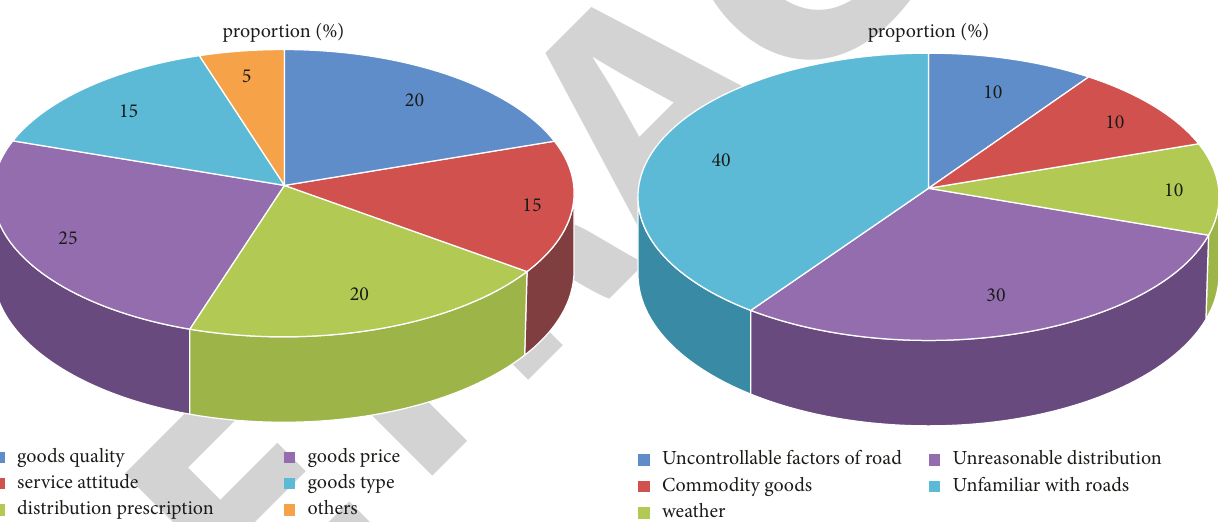
Figure 4: The chart of main factors affecting customers’ shopping experience.